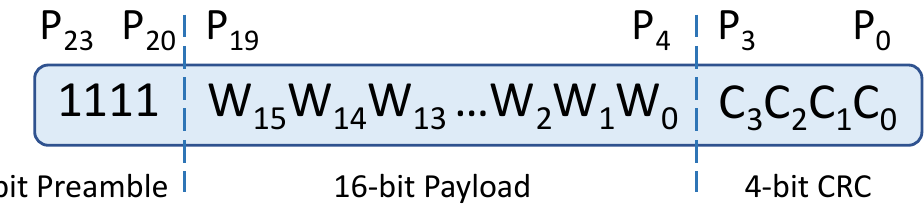
Figure 3. Format of the 24-bit data packet P 23-0 . It is composed by the CRC C 3-0 , the payload W 15-0 , and the fixed preamble “1111”.